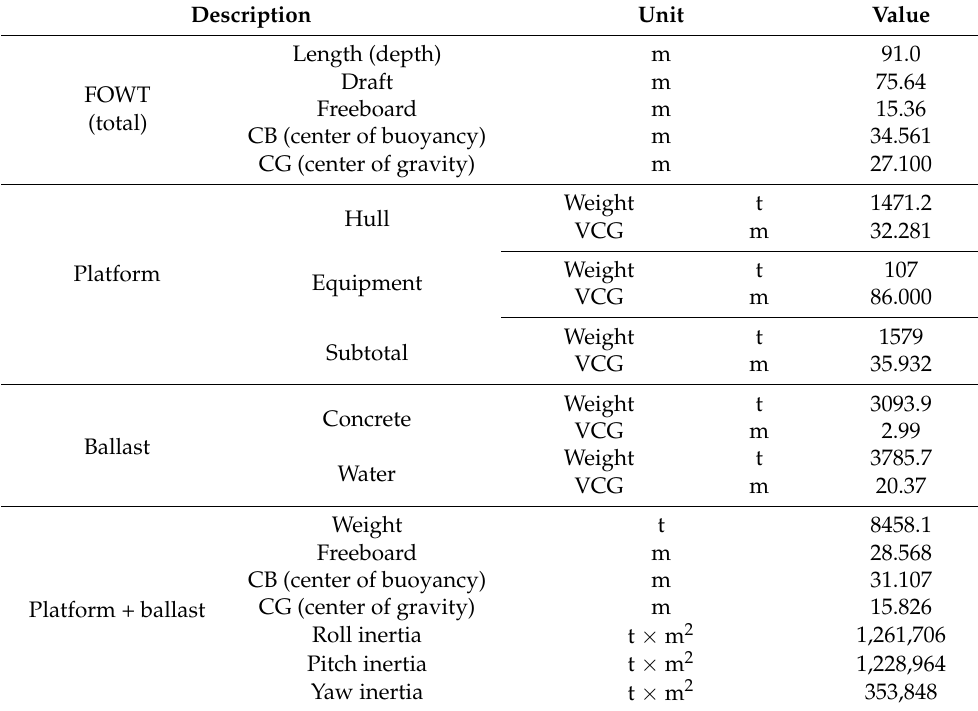
Table 3. Structural characteristics of 5 MW floating